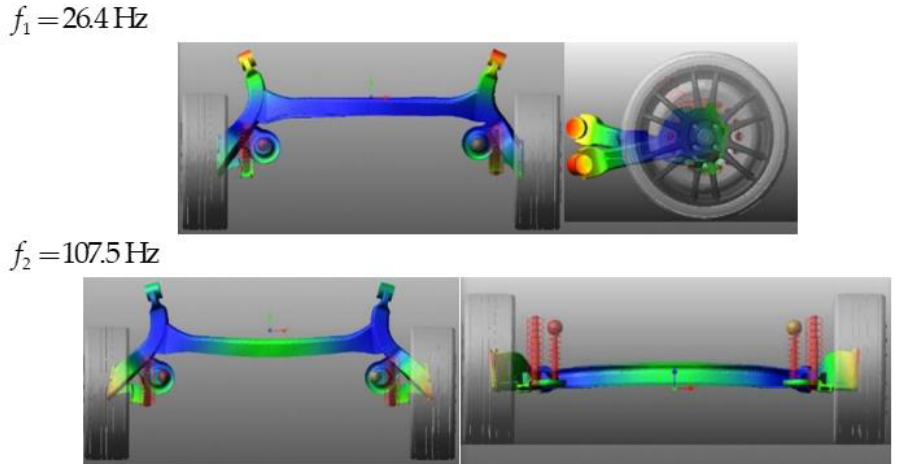
Figure 9. The suspension beam’s natural frequencies and its mode shapes.